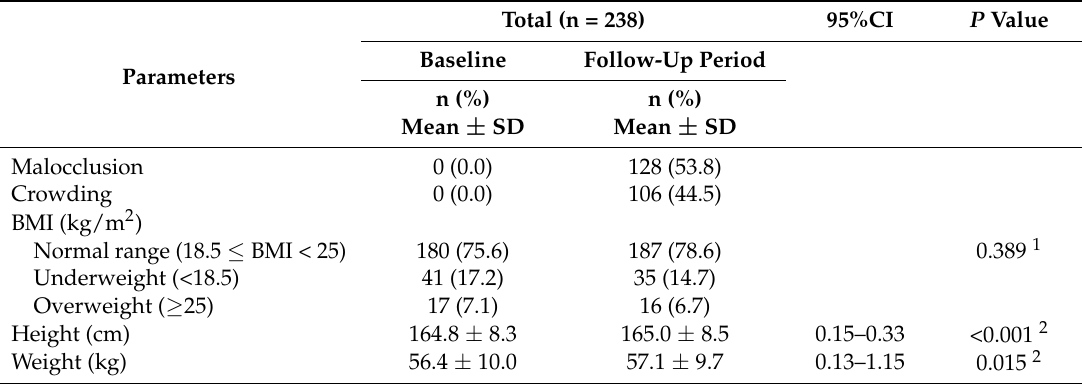
Table 2. Changes in parameters from baseline to re-examination among Okayama University students, Japan, 2013–2016.